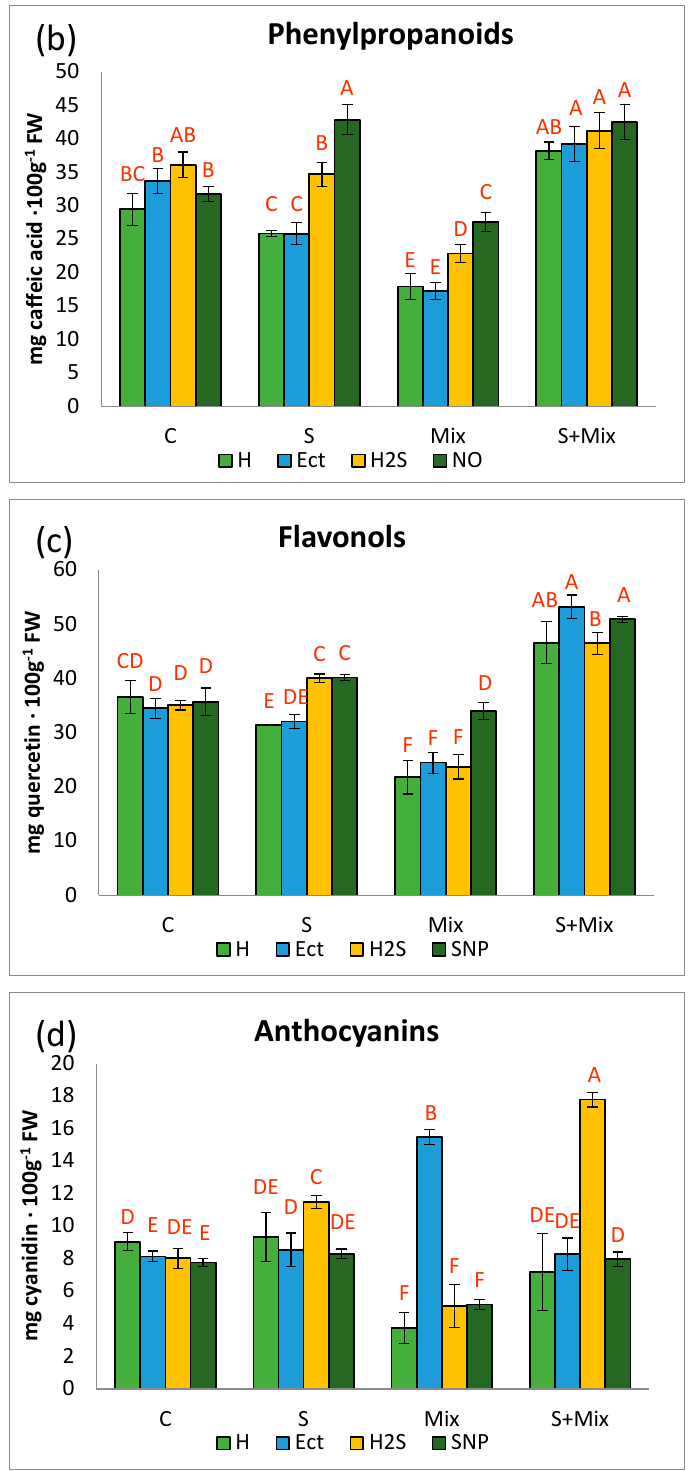
Figure 3. Phenolic profile in Lobularia maritima shoots subjected to priming prior to stress exposure: ( a ) total phenolic content; ( b ) phenylpropanoids; ( c ) flavonols; ( d ) anthocyanins. Upper case letters indicate statistical significance of means acc. two-way ANOVA. Applied primers: H—water (hy- dropriming), Ect—ectoine, H2S—hydrogen sulfide donor GYY4137, NO—nitric oxide donor sodium nitroprusside. Treatments: C—control; S—low salinity (20 mM NaCl); Mix—metals: 0.7 mM ZnSO 4 , 16 µ M CdCl 2 , 3 µ M PbCl 2 ; S + Mix—salinity combined with